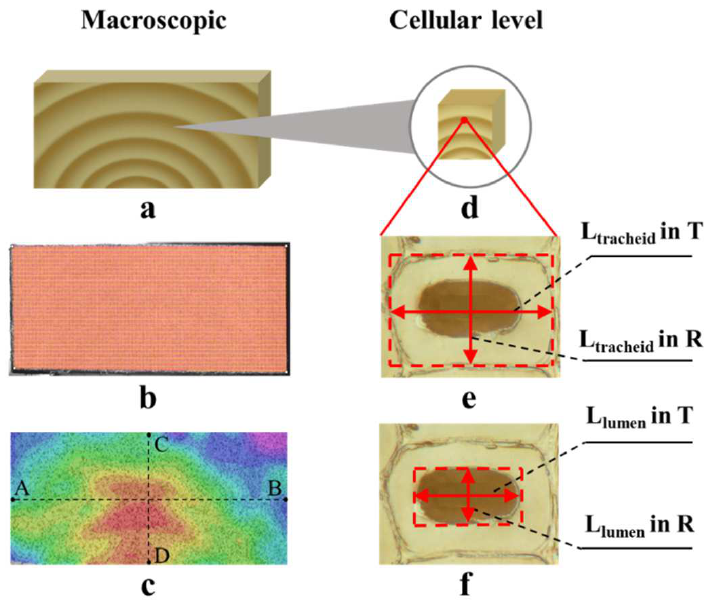
Figure 1. Schematic diagram of sample preparation for macroscopic ( a ) and cellular level ( d ), selected areas of interest ( b ), shrinkage strain analysis ( c ), determination for tracheid dimension ( e ), and determination for lumen dimension ( f ). The points A, B, C and D were selected to track the change in specimen dimension. L tracheid in the T and R indicate the length of the tracheid in the tangential and radial directions, respectively. L lumen in the T and R indicate the length of the lumen in the tangential and radial directions, respectively.